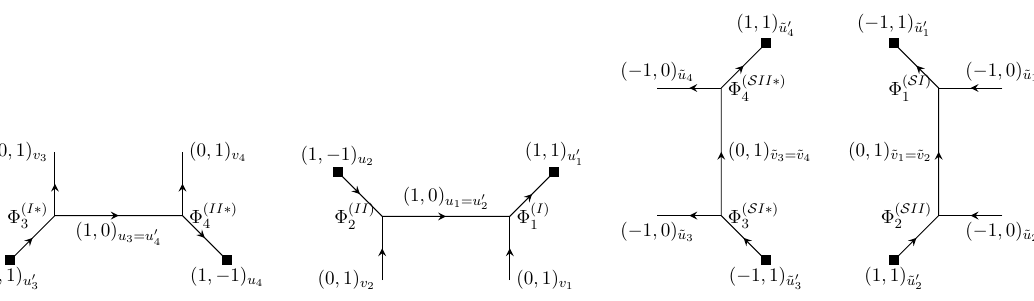
Figure 7 . Representation of the Gaiotto states j G;~v ii , hh G;~v j and the S-dual states (the black squares represent projections on the vacuum